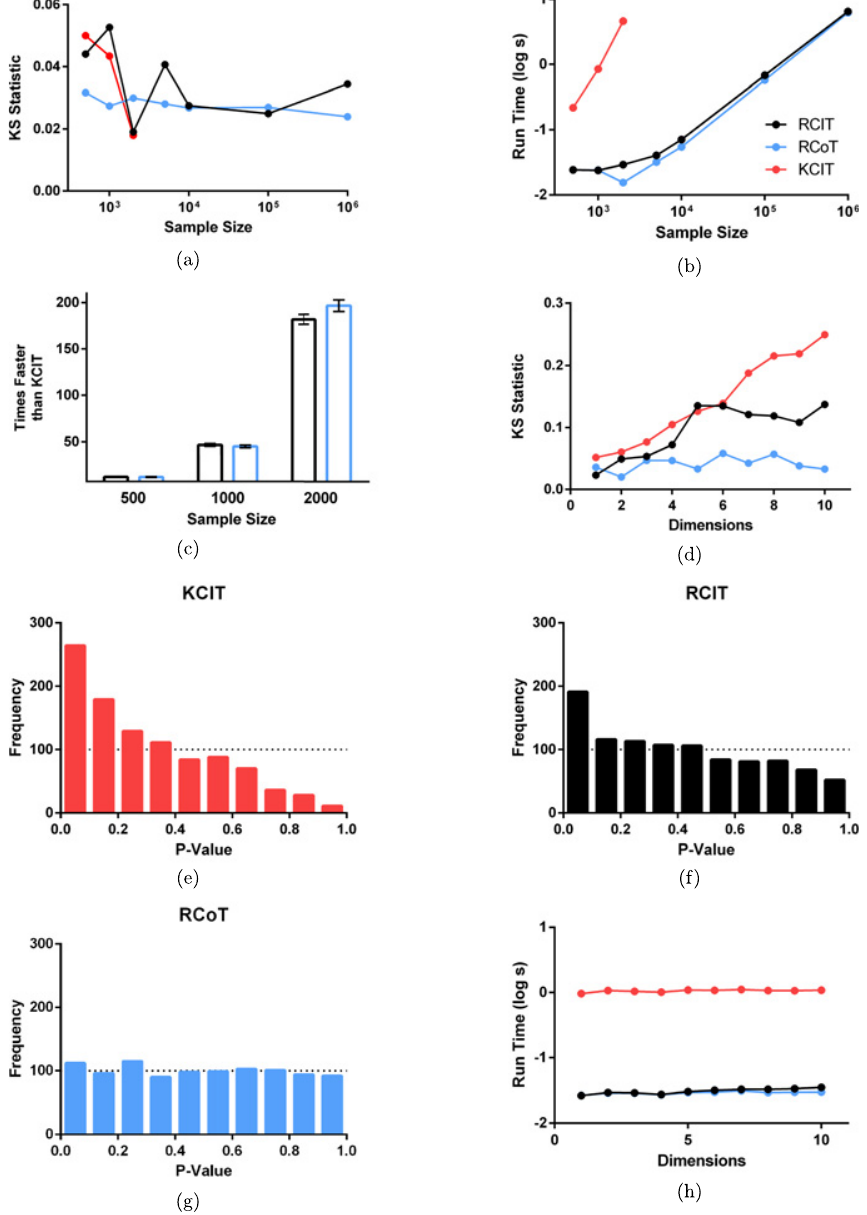
Figure 1: Experimental results of RCIT, RCoT and KCIT when conditional independence holds. (a) All tests have comparable KS statistic values as a function of sample size. (b) However, both RCIT and RCoT complete much faster than KCIT. (c) The relative difference in speed between RCIT vs. KCIT and RCoT vs. KCIT grows with increasing sample size. (d) RCoT maintains the lowest KS statistic value with increases in dimensionality. (e–g) Histograms with a conditioning set size of 10 show that KCIT, RCIT and RCoT obtain progressively more uniform null distributions. (h) Run times of all three tests scale linearly with dimensionality of the conditioning